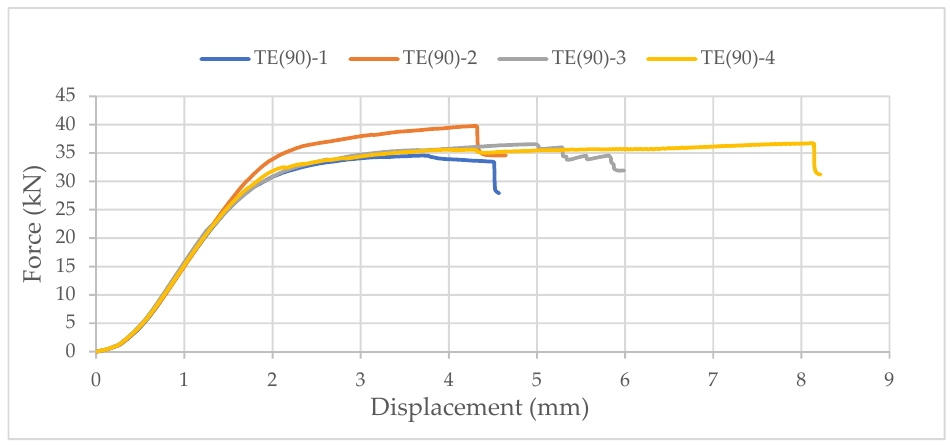
Figure 24. The force-displacement curve for compression perpendicular to the grain of samples with elliptical cavities in the direction of the stronger axis.